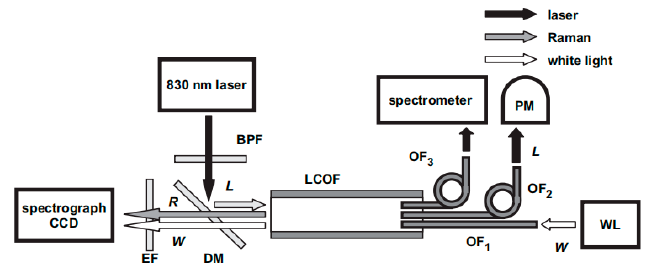
Figure 18. The experimental device for detecting Raman spectra and absorption spectra using LOF. Reprinted with permission from [99] © The Optical Society.